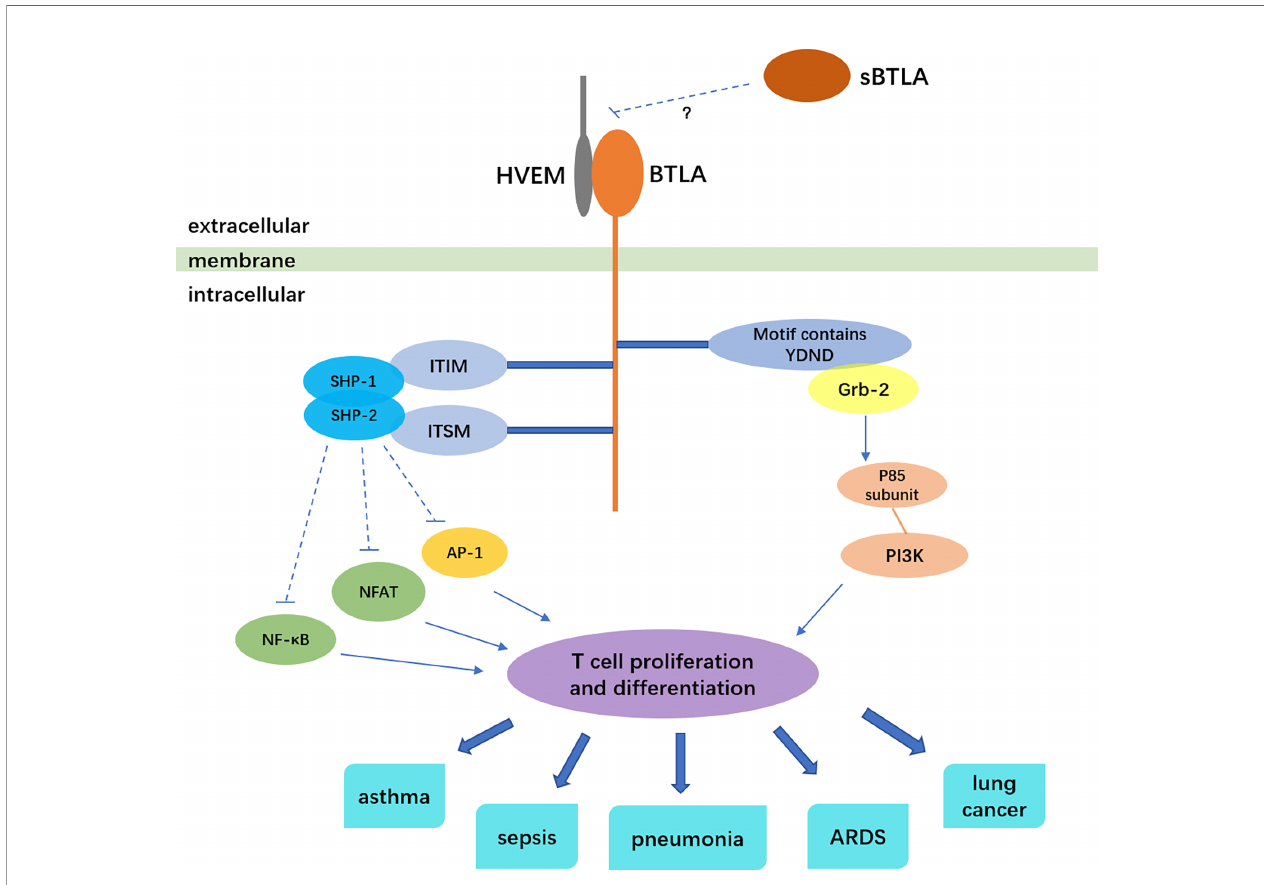
FIGURE 1 | BTLA signaling and the relation to respiratory diseases. The solid arrows indicate stimulatory effect, the dotted lines indicate inhibitory